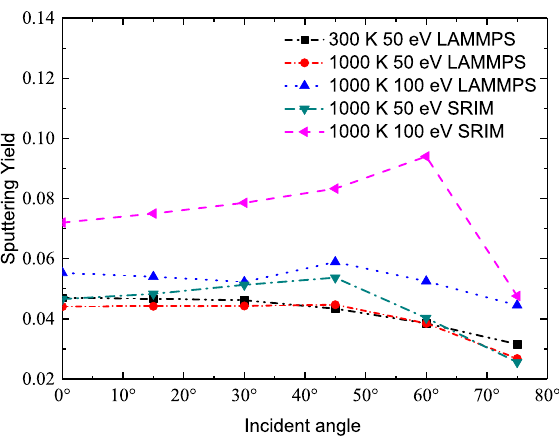
Figure 4. Sputtering yield of SiC bulk with 62 at % C concentration as a function of the incident angle.